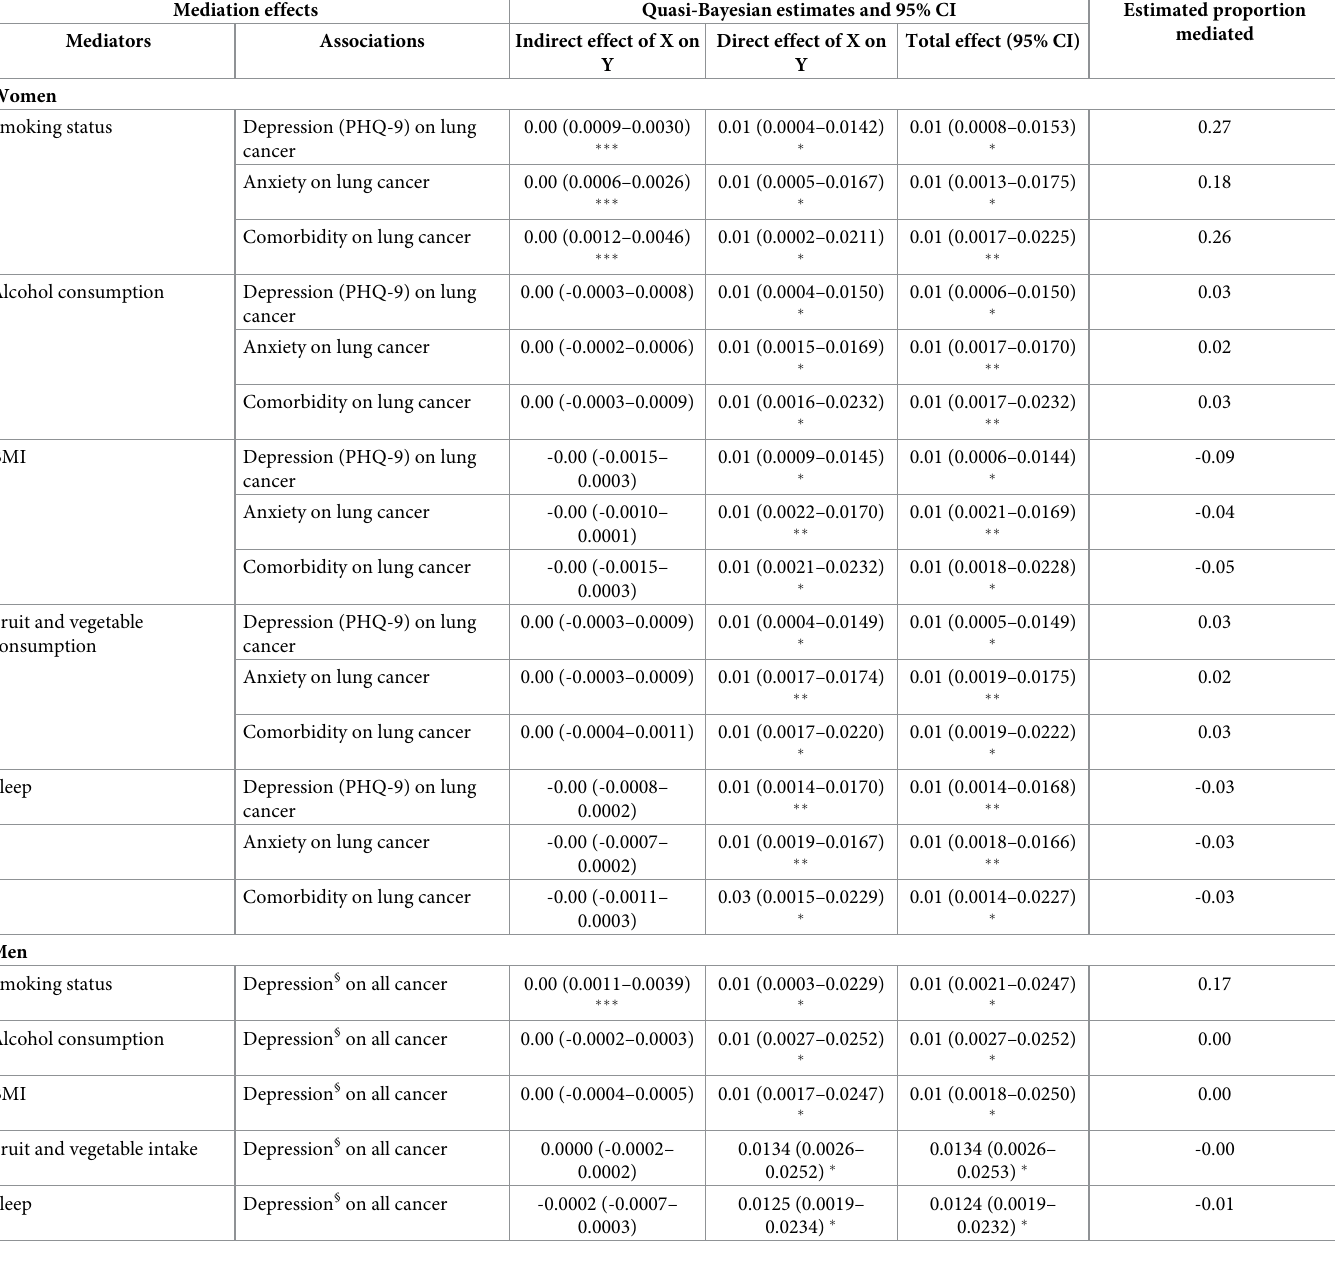
Table 7. Mediation effects of lifestyle factors in the relationship between mental health and lung cancer in women and all cancer in men a, b